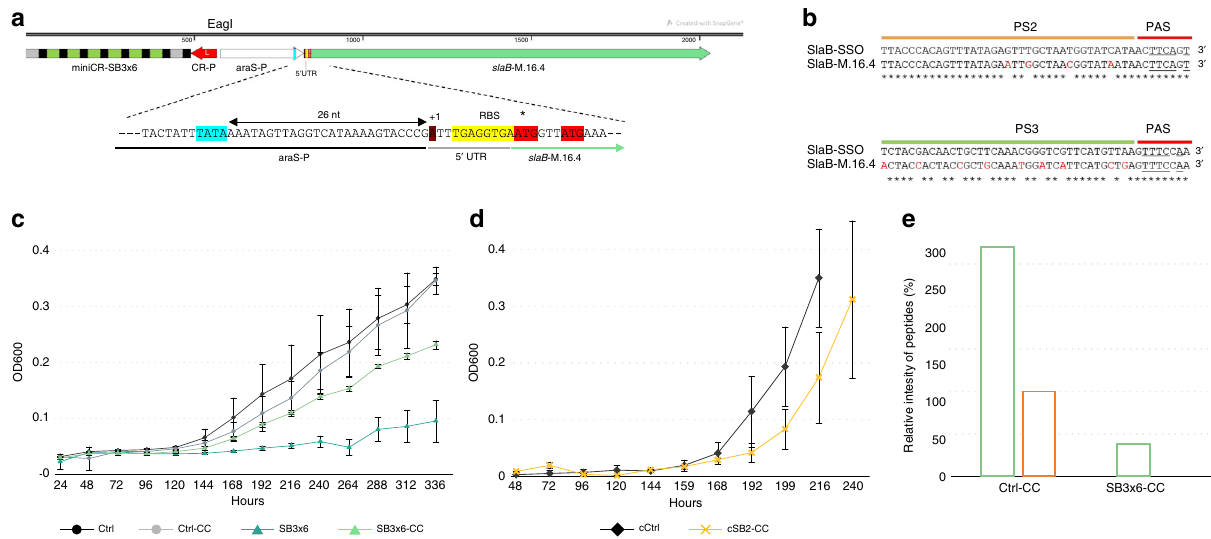
Fig. 2 Complementation of slaB . a Fusion product of SB3×6 miniCR (CRISPR-promoter, red) and the complementation cassette: arabinose-inducible promoter: araS-P (TATA box, blue), 5 ′ -UTR of slaB S. islandicus M.16.4 (M164_1762) including the putative TSS (dark red), a native ribosomal binding site (RBS, yellow) and two potential translation starts (ATG, red). b Nucleotide sequence alignment of S. solfataricus protospacer 2 and 3 ( slaB -SSO) and respective regions on S. islandicus M.16.4 slaB gene ( slaB -M.16.4). Asterisks: matching nucleotide; red: mismatches; underlined: PAS-5 ′ crRNA handle complementarity. c Optical density increase (arabinose supplemented medium) of pIZ-plasmid primary cultures carrying silencing constructs, control constructs (Ctrl) and complementation constructs (-CC), respectively. Dark gray (circle): control; light gray (circle): control-CC; petrol (triangle): SB3×6; light petrol (triangle): SB3×6-CC. Error bars, mean±SD (three biol. replicates). d Optical density increase (arabinose supplemented medium) of pIZ-plasmid cultures recovered from single colonies (pre fi x “ c ” ) control and complementation constructs. Dark gray (rectangle): control; yellow (x): SB2-CC. Error bars, mean ±SD (three biol. replicates). e Relative intensity values (MaxQuant) of SlaB peptides of S. solfataricus and S. islandicus detected by mass spectrometry in Ctrl-CC and